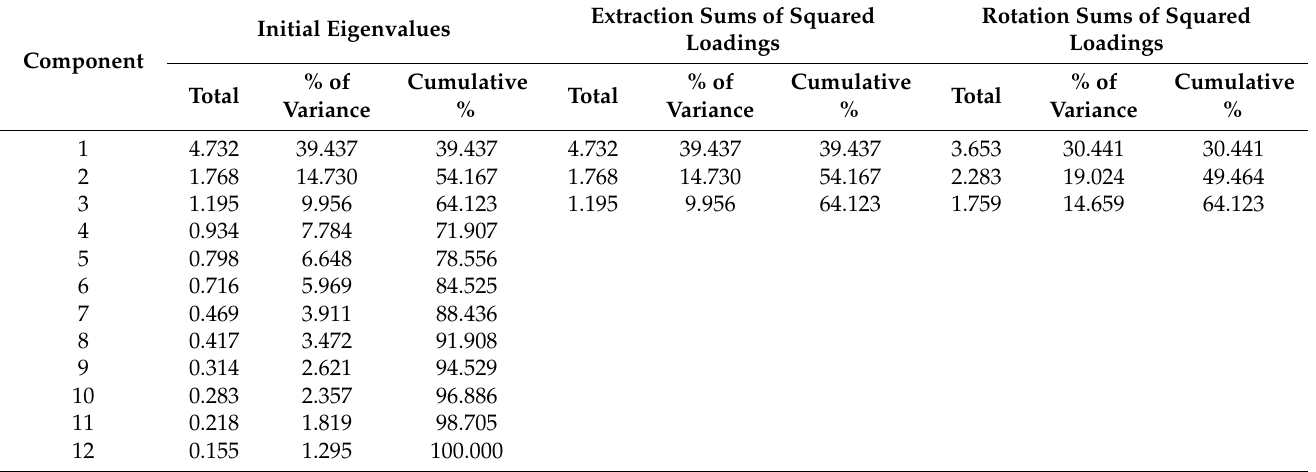
Figure 2. Factor analysis results: Scree plot. Table 6. Total variance explained.